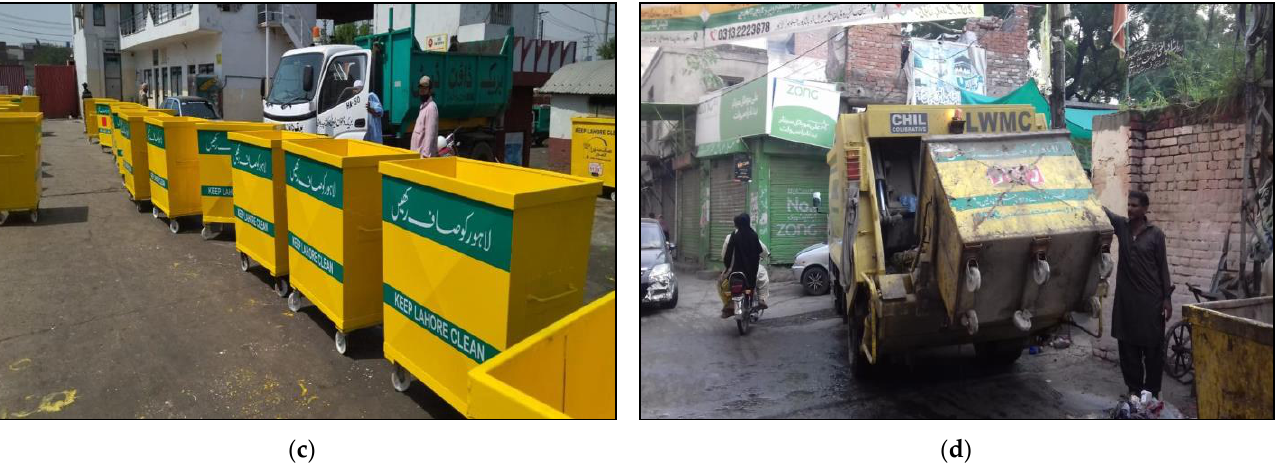
Figure 10. Equipment and machinery for waste collection: ( a ) Fleet quantity to perform city cleaning operations; ( b ) Town-wise consumption of fuel/month to perform cleanliness operations; ( c ) In-house fabrication of waste storage containers; ( d ) New fleet added in the system to improve collection efficiency.